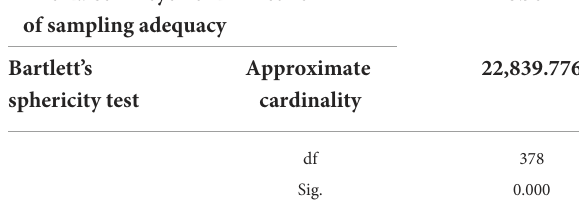
TABLE 2 KMO and Bartlett’s test of the